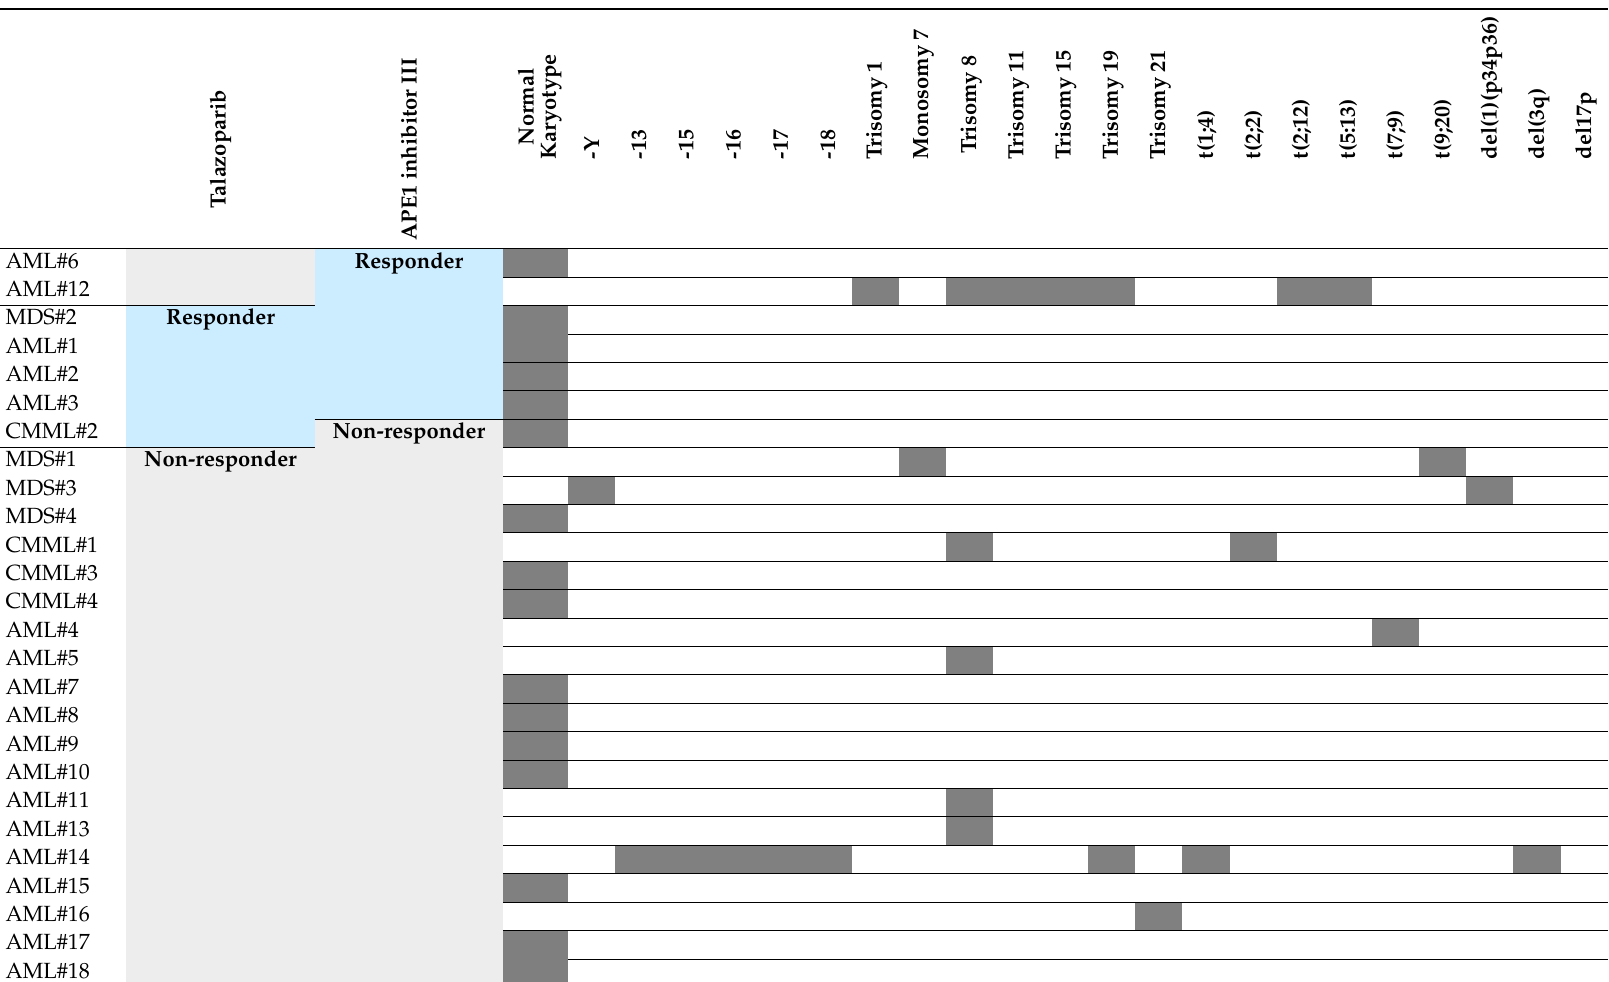
Table 2. Cytotoxic e ffi cacy of talazoparib and APE1 inhibitor III in myelodysplastic syndromes / chronic myelomonocytic leukemias and acute myeloid leukemias in relation to chromosomal aberrations. AML: acute myeloid leukemia; CMML: chronic myelomonocytic leukemia; MDS: myelodysplastic